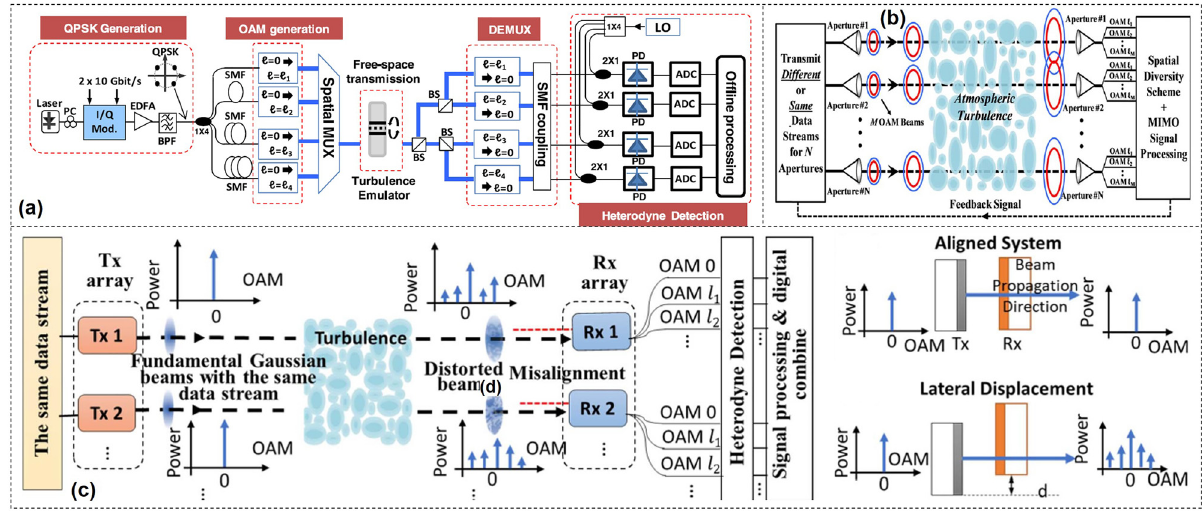
Figure 16: Turbulence compensation based on digital signal processing. (a) Block diagram for the demonstration of MIMO-based turbulence mitigation [116]. (b) Concept of spatial diversity assisted MIMO equalization for turbulence mitigation [118]. (c) Concept of the free-space optical communication link combining aperture diversity and the multimode receiver [119]. Reprint permission obtained from [116, 118, 119].